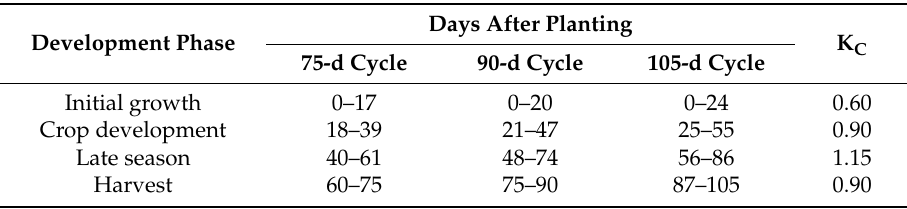
Table 1. Days after planting and crop coefficient (K C ) for each development phase for three generic varieties of tomato with 75-d, 90-d and 105-d growing cycle. Based on